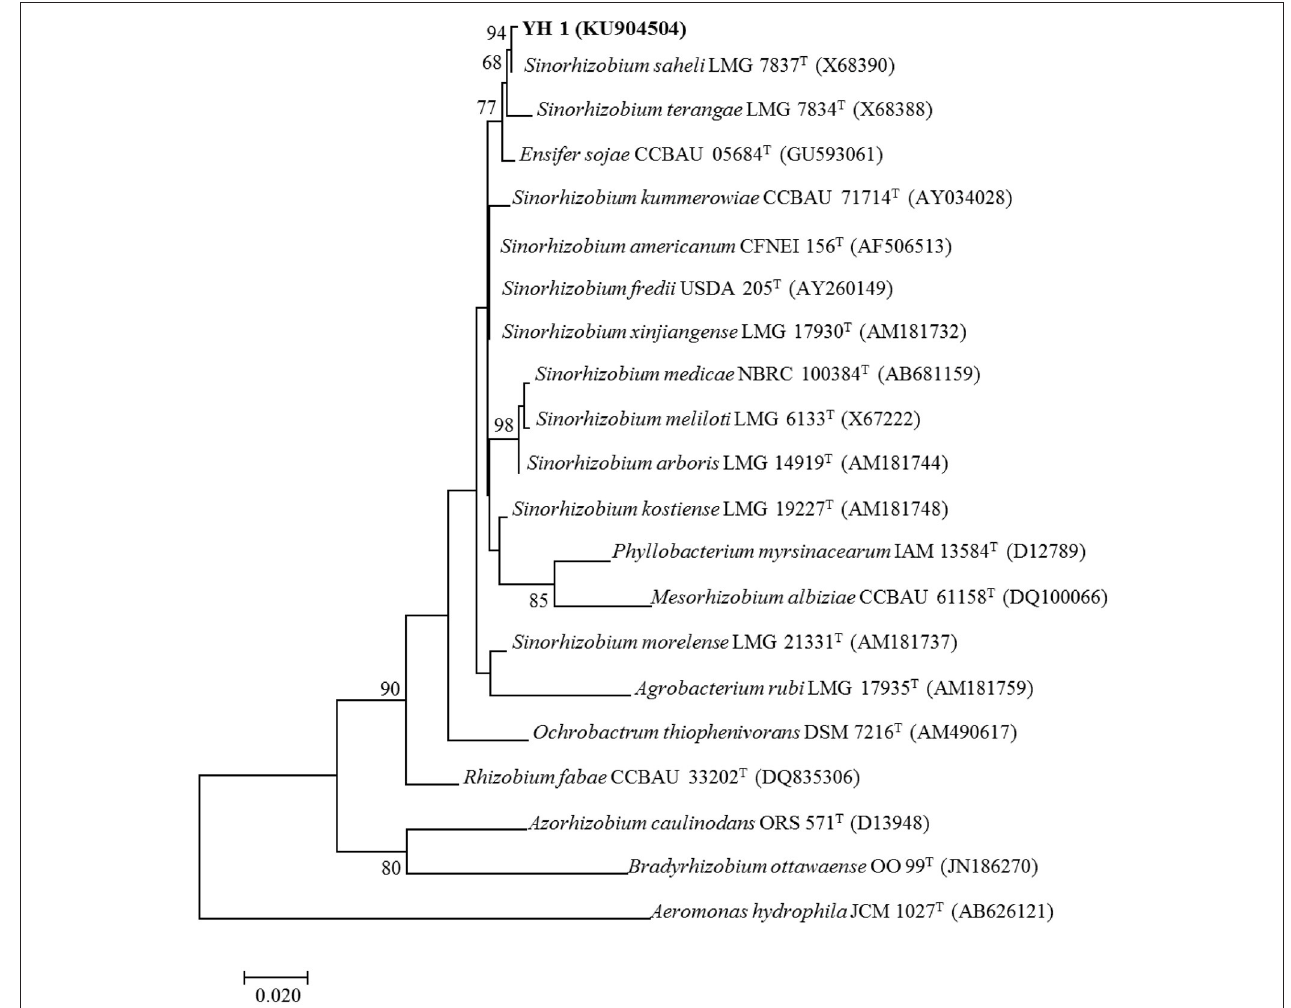
FIGURE 2 | 16S rRNA phylogenetic tree (1,404 bp) of L. leucocephala -isolated strain YH1 created using maximum likelihood method with the Kimura 2-parameter model. Bootstrap confidence level is based on 1,000 iterations. Accession numbers retrieved from GenBank are shown in parentheses. The scale bar implies 2% nucleotide substitutions per site. Values lower than 50 are not shown at the nodes. Superscript “T” following each strain number indicates type